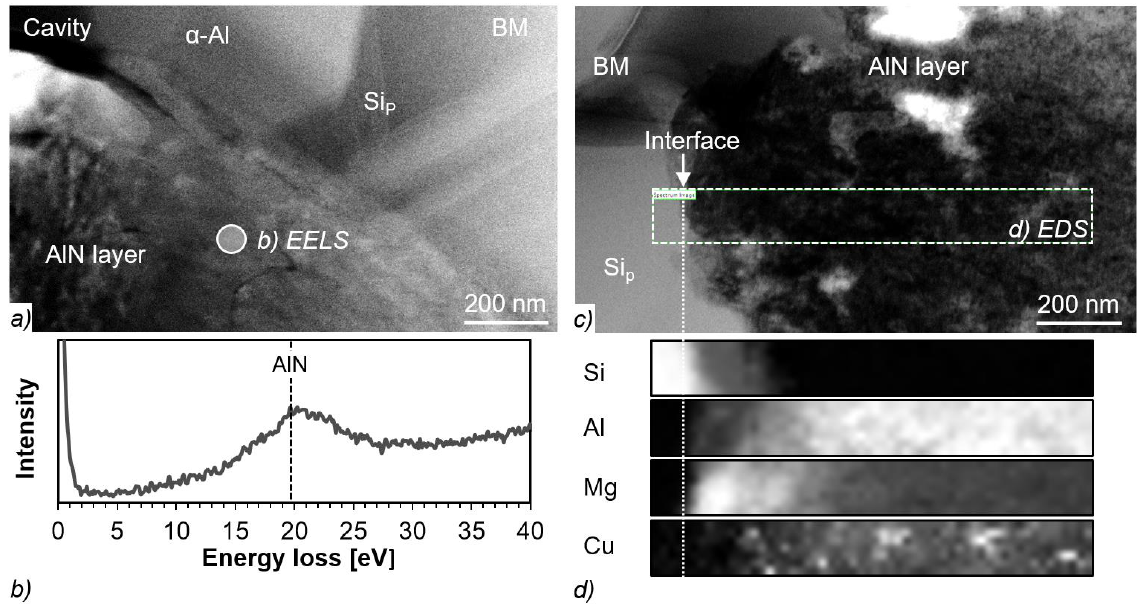
Figure 9. Analysis of the interface between primary silicon Si P and the AlN layer: ( a ) TEM image (df) of a cross section with point of EELS measuring, ( b ) low-loss spectrum; ( c ) TEM image (bf) of a cross section with an EDS measuring field; ( d ) EDS mapping for the elements Al, Mg, Si, Cu.